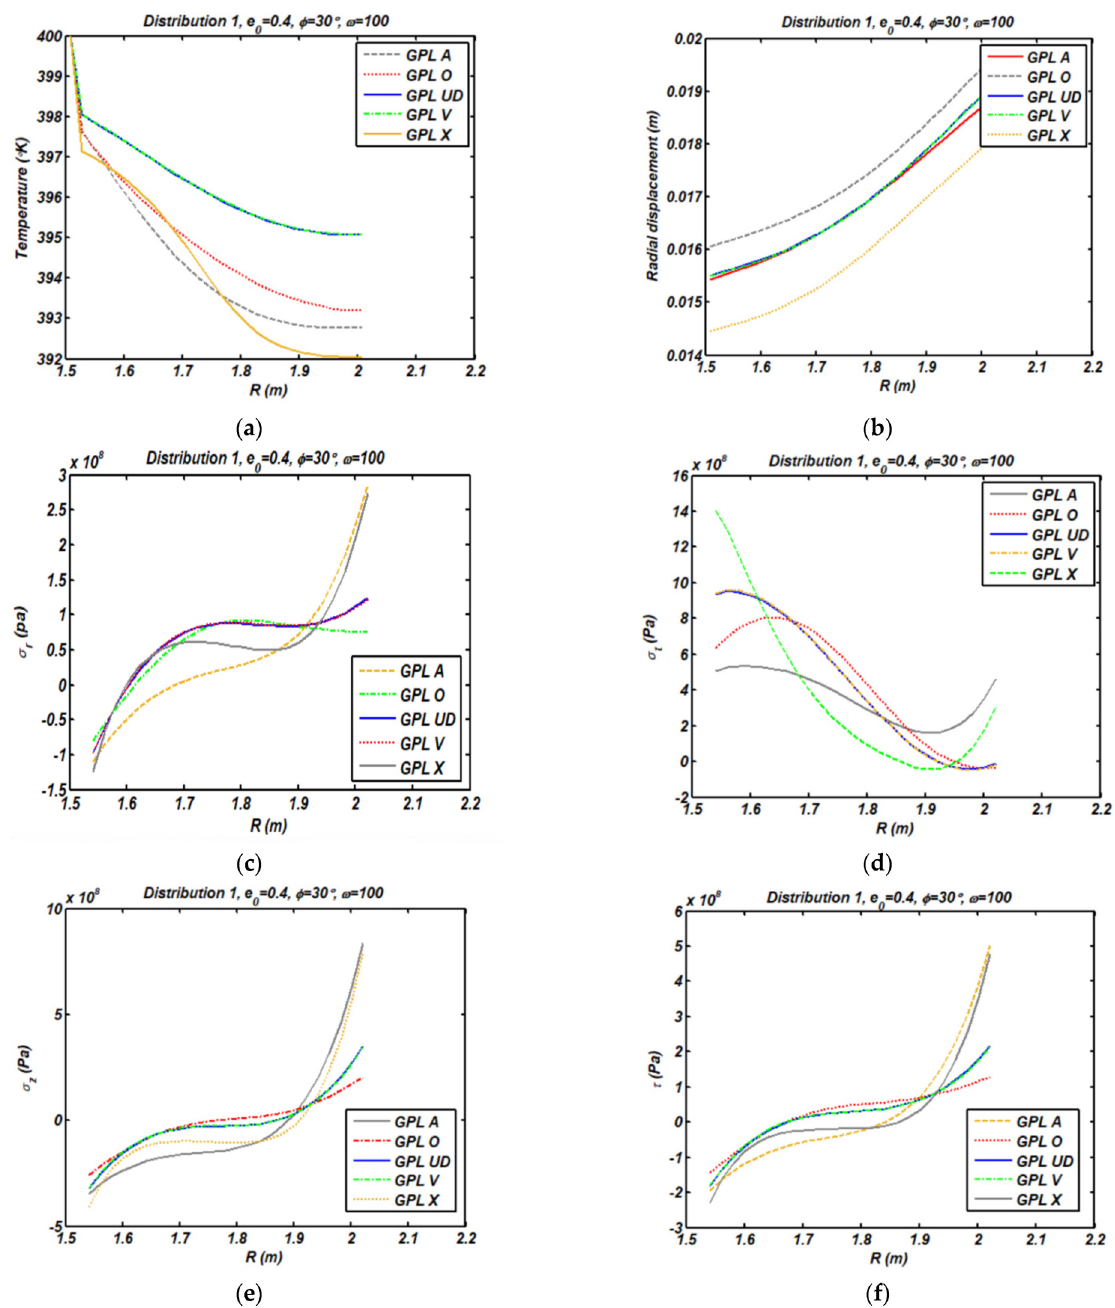
Figure 9. Temperature ( a ), radial displacement ( b ), and stress state ( c – f ) at z = L /2 for various GPL patterns (D1; e 0 = 0.4; γ GPL = 0.01; ω = 100